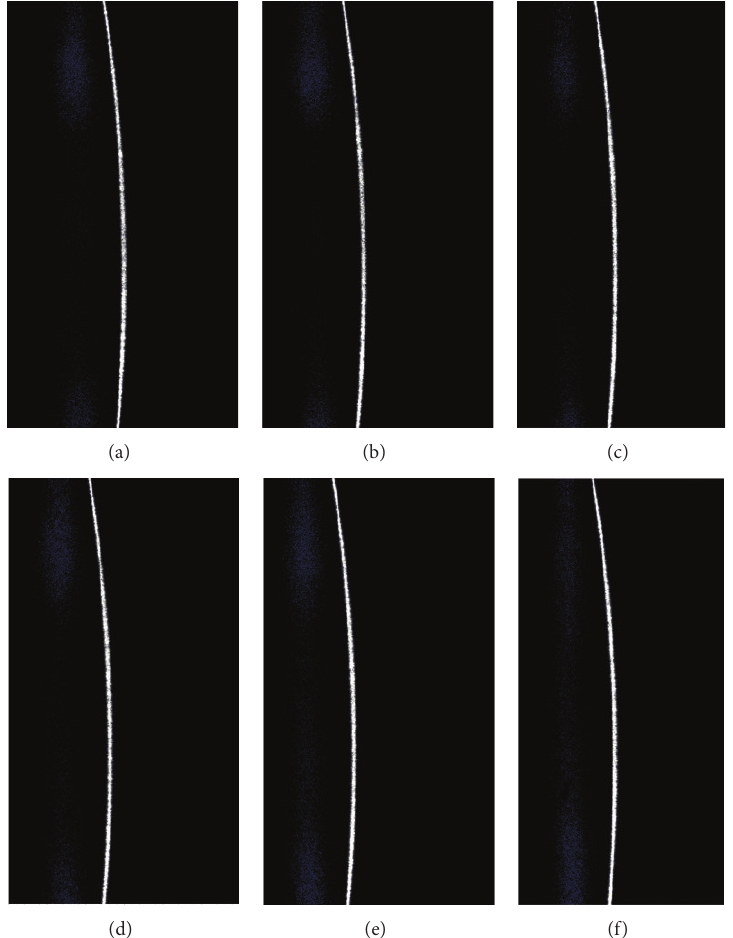
Figure 6: Experimentally obtained image of arcs (part of cutting circles) with 2mm moving step of line-structure light.